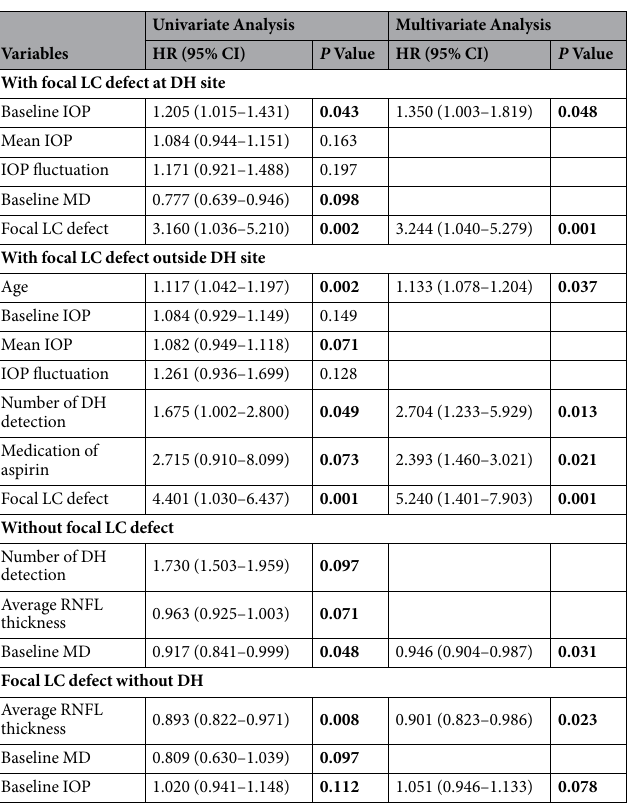
Table 6. Cox proportional hazards univariate and multivariate analysis of visual field progression in glaucoma patients with disc hemorrhage according to the findings of the lamina cribrosa. CI, confidence interval; HR, hazard ratio; D, diopters; IOP, intraocular pressure; RNFL, retinal nerve fiber layer; DH, disc hemorrhage; LC, lamina cribrosa; MD, mean deviation; PSD, pattern standard deviation; VF, visual field. Variables with P < 0.10 are shown in bold (Univariate analysis). Variables with P < 0.05 are shown in bold (Multivariate